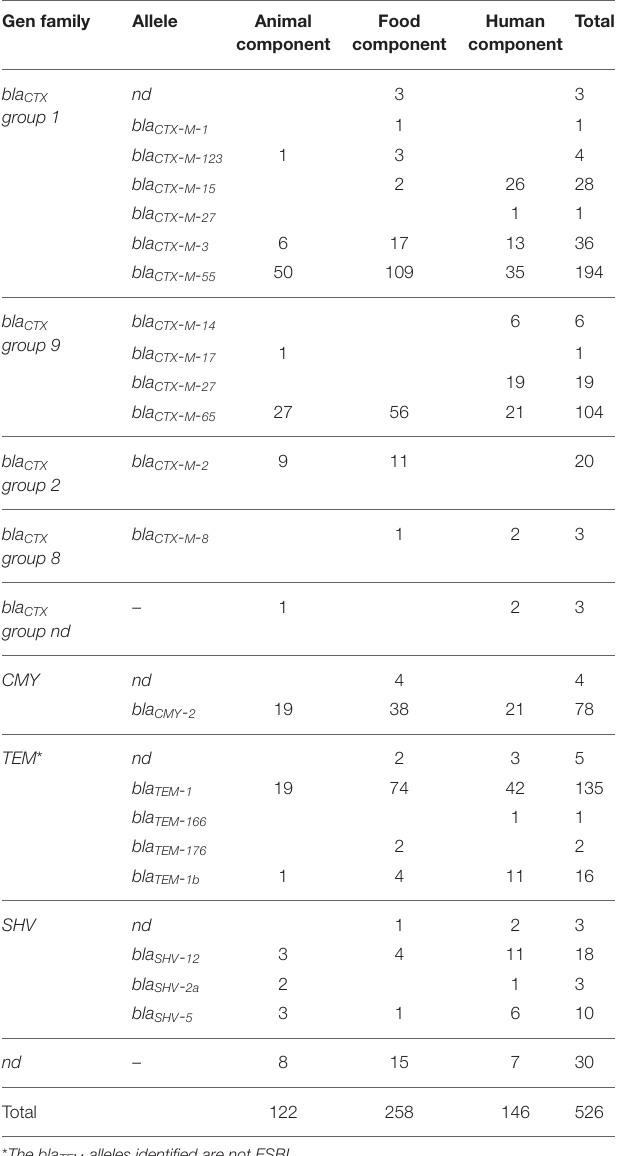
TABLE 3 | Prevalence of ESBL/AmpC genes in the cefotaxime-resistant Escherichia coli isolates. Gen family